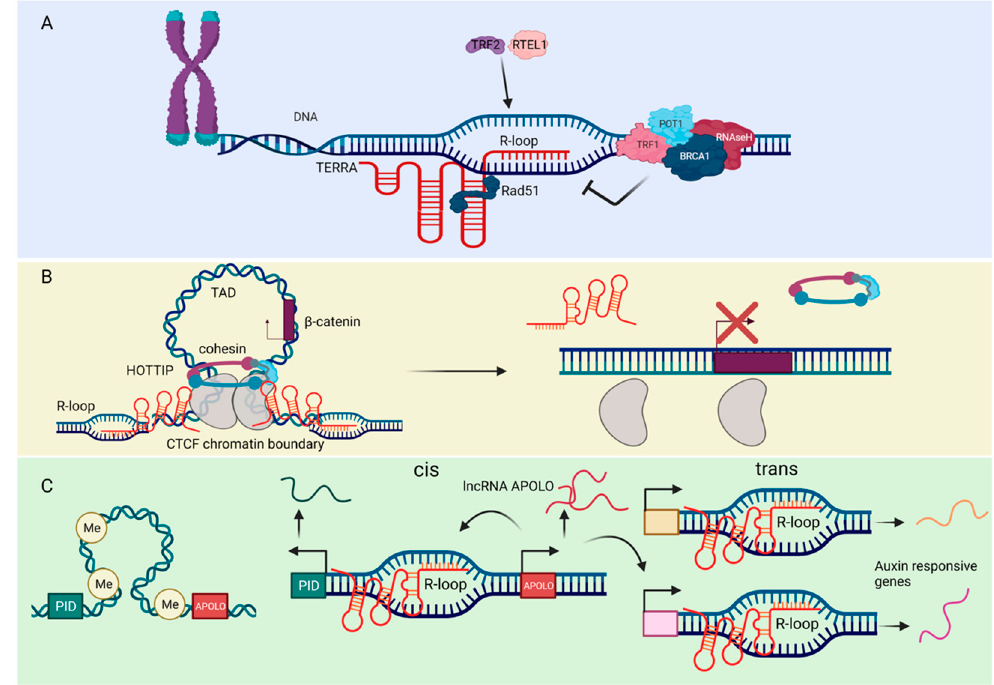
Figure 3. The roles of ncRNAs in the formation of R-loops. ( A ) The lncRNA TERRA binds to telomeres through direct base-pairing with telomeric DNA, forming the R-loop structure. The RAD51 DNA recombinase binds TERRA and thus catalyzes TERRA R-loop formation. The helicase RTEL1 and the telomeric shelterin component TRF2 also promote TERRA association with chromosome ends and stimulate R-loop formation. TRF1 and POT1 play a role in preventing the accumulation of such structures. The DNA recombination factor BRCA1 modulate TERRA binding to telomeres, pre- venting R-loop-associated telomeric DNA damage. TERRA R-loops are regulated by endonucleo- lytic cleavage activity of RNase H, which removes the RNA-DNA hybrids. ( B ) The lncRNA HOTTIP is highly expressed in acute myeloid leukemia. HOTTIP directly interacts with and regulates CTCF/cohesin complex and form R-loops. HOTTIP -mediated R-loops facilitate formation of topo- logically associating domain (TAD) to drive gene transcription of β -catenin. Eliminating HOTTIP - guided R-loops by targeting RNase H or removing CTCF-binding sites affect TAD structure, leading to alleviating leukemia severity. ( C ) The cis and trans regulatory mechanisms of the lncRNA APOLO . Under normal physiological conditions, APOLO is not transcribed due to hypermethyla- tion of its promoter and chromosomal looping. However, during the lateral root development, the plant hormone Auxin induces the transcription of APOLO . The transcribed APOLO forms R-loops and thus modulates the chromatin looping in cis and trans, thereby enhancing transcription of auxin responsive genes and lateral root development. The figure was created with BioRender.com, ac- cessed on 17 March 2022. R-loops form readily both from protein-coding and non-coding RNA species, partic- ularly lncRNAs [109,128]. However, unlike protein-coding RNA species, lncRNAs form R-loops both in cis (re-annealing to their DNA template) and in trans (annealing to a distal